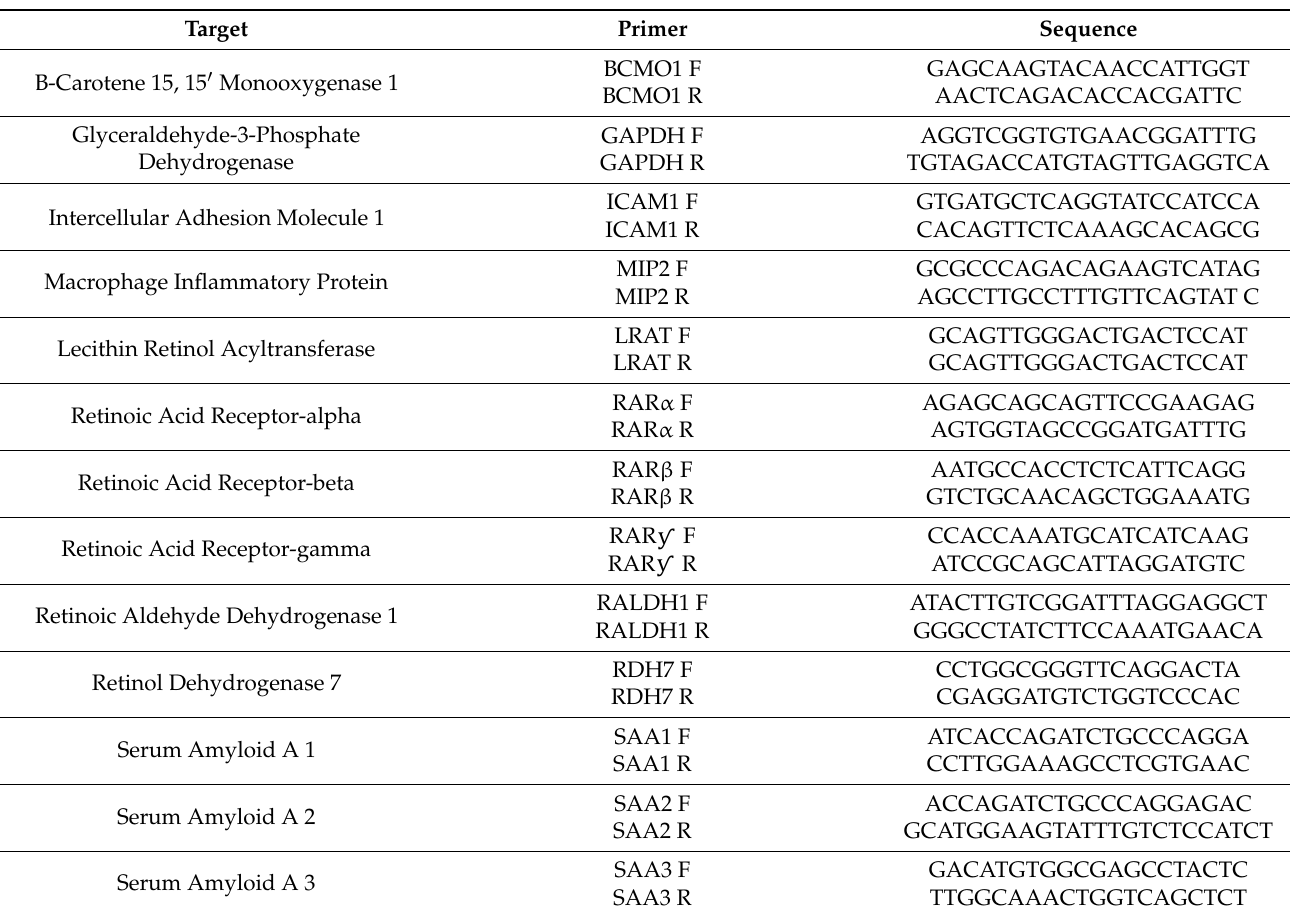
Table 2. Gene Primer Sequences.